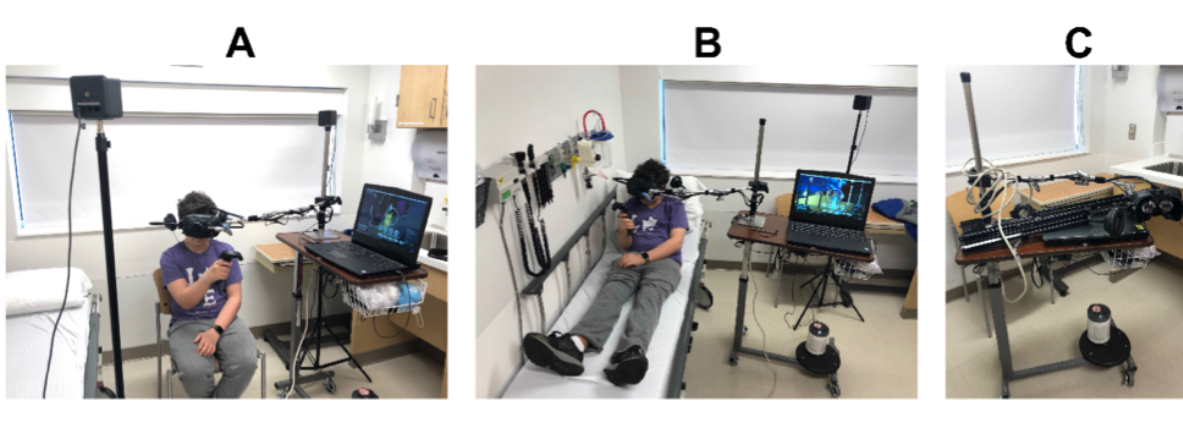
Figure 2. Virtual reality–based interactive cognitive wheeled workstation. Operated with a child sitting in a chair (left). The child operating the program while reclining in bed (middle). Equipment is sanitized after each use and stored as a compact and portable workstation